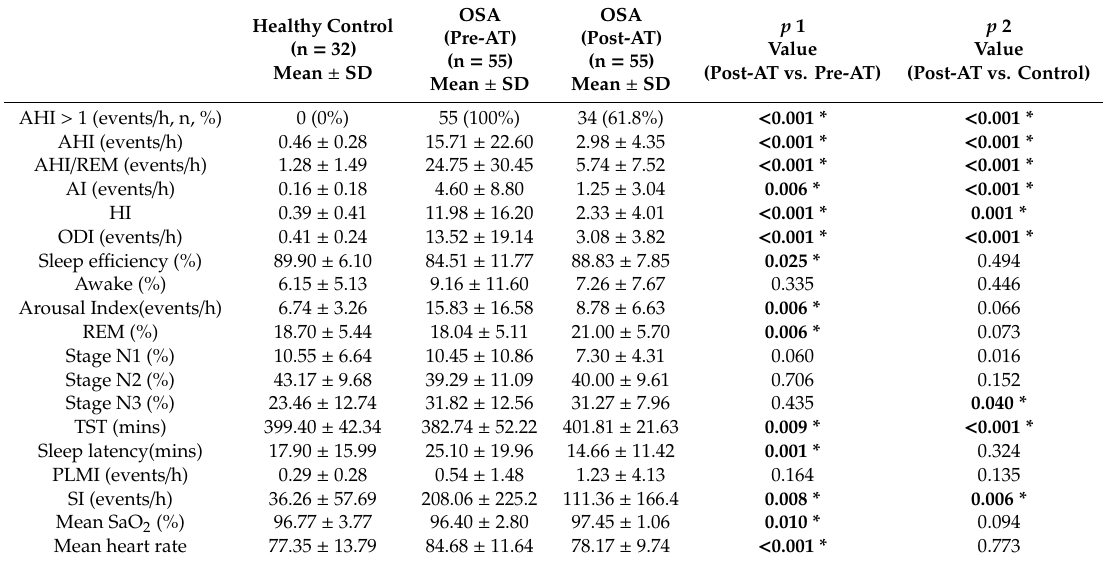
Table 2. Comparison of polysomnography findings between